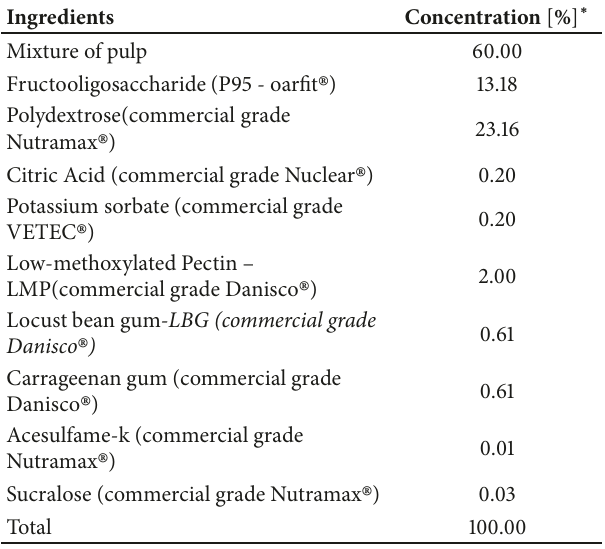
Table 1: Formulation used in the production of dietetic functional mixed cerrado fruit